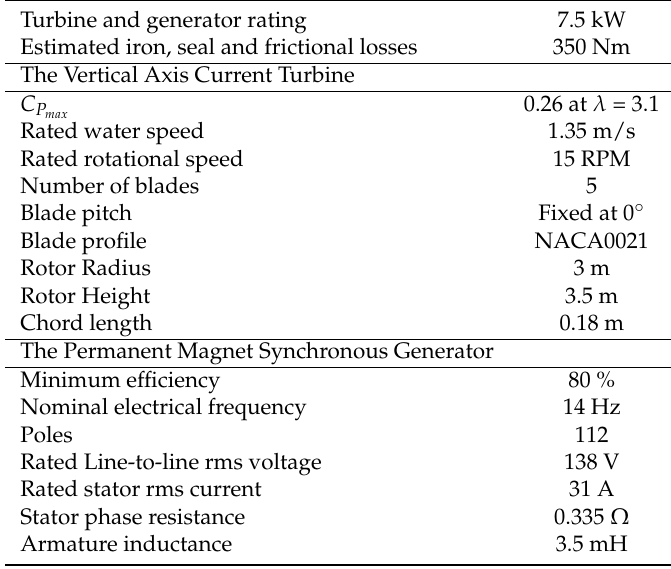
Table 1. Turbine and generator specifications at rated operation.